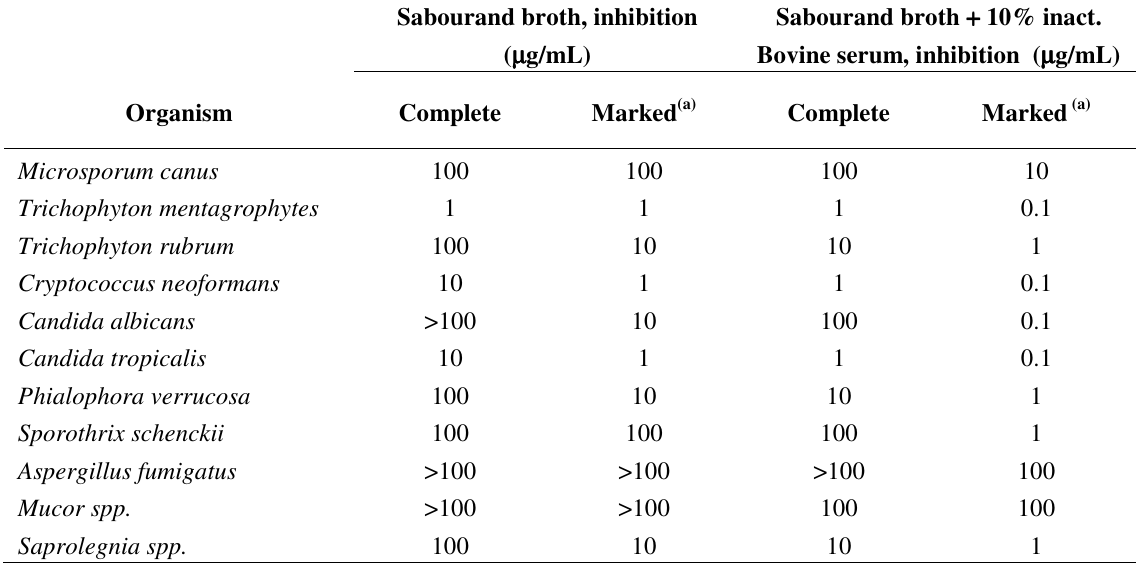
Table 4. In vitro antifungal activity of terconazole: Complete or Marked inhibition of growth at the concentrations indicated in Sabourand broth after 14 days of incubation of terconazole [10]. Sabourand broth, inhibition Sabourand broth ++++ 10% ( µµµµ g/mL)